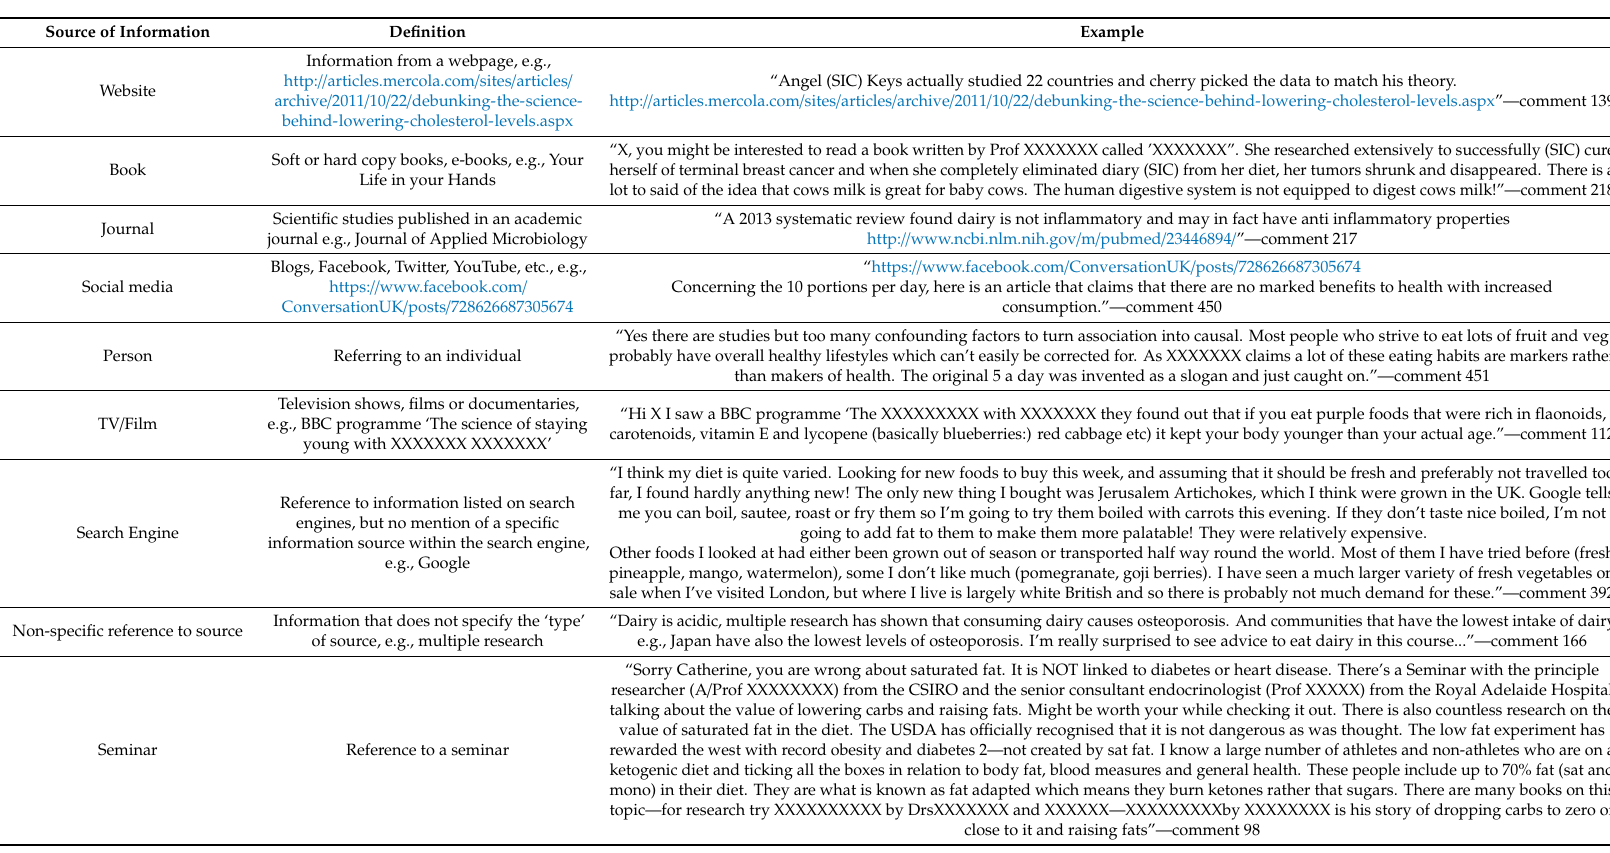
Table A1. Source of information